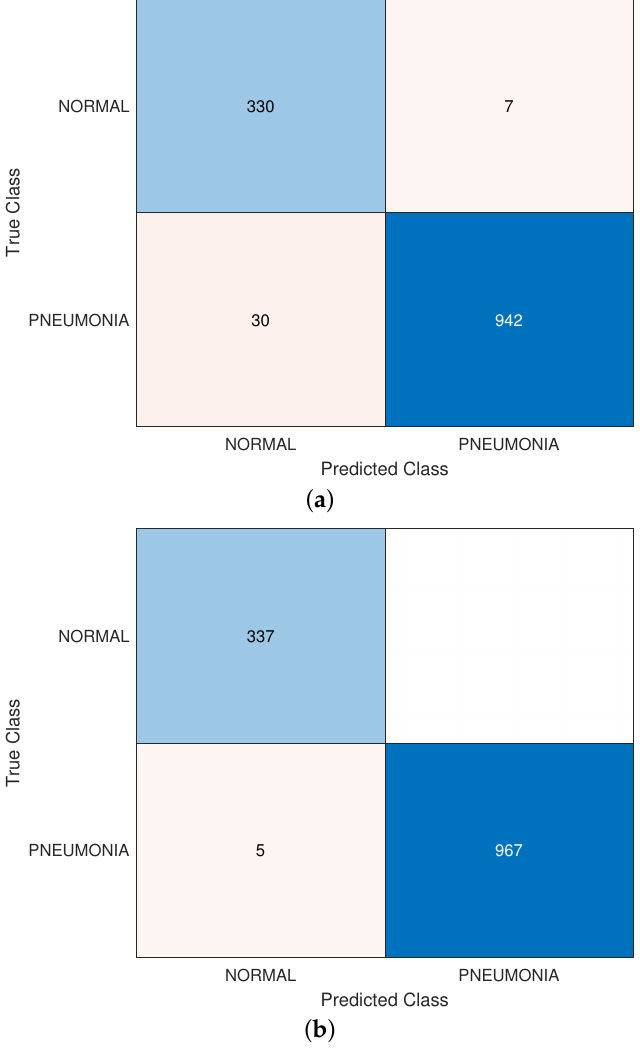
Figure 7. The confusion matrices showing a comparison between ( a ) deep-layer features and ( b ) fea- tures extracted using proposed